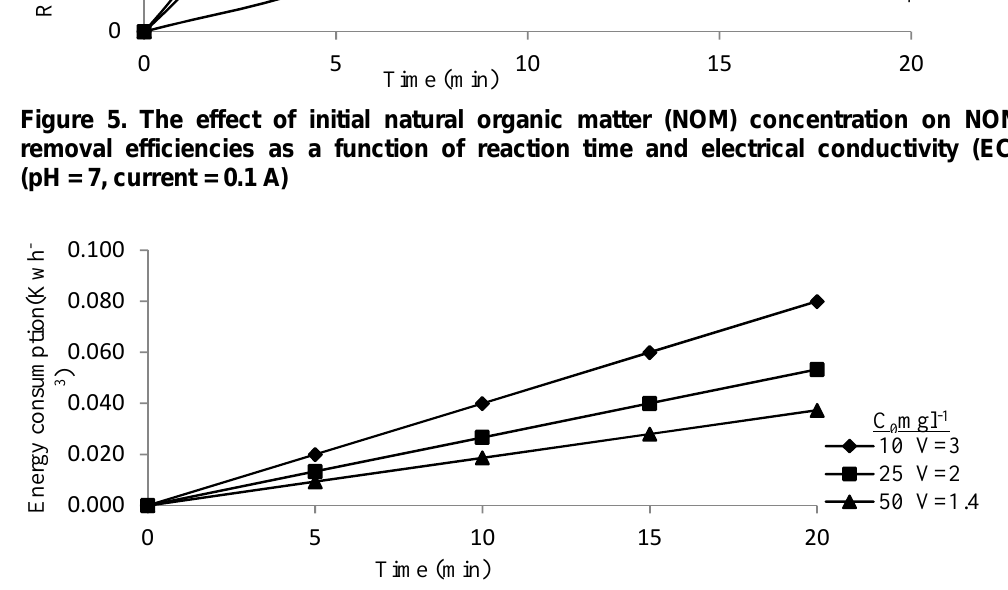
Figure 6. The effects of initial concentrations on the electrical energy consumption at optimum condition (pH = 7 and current = 0.1